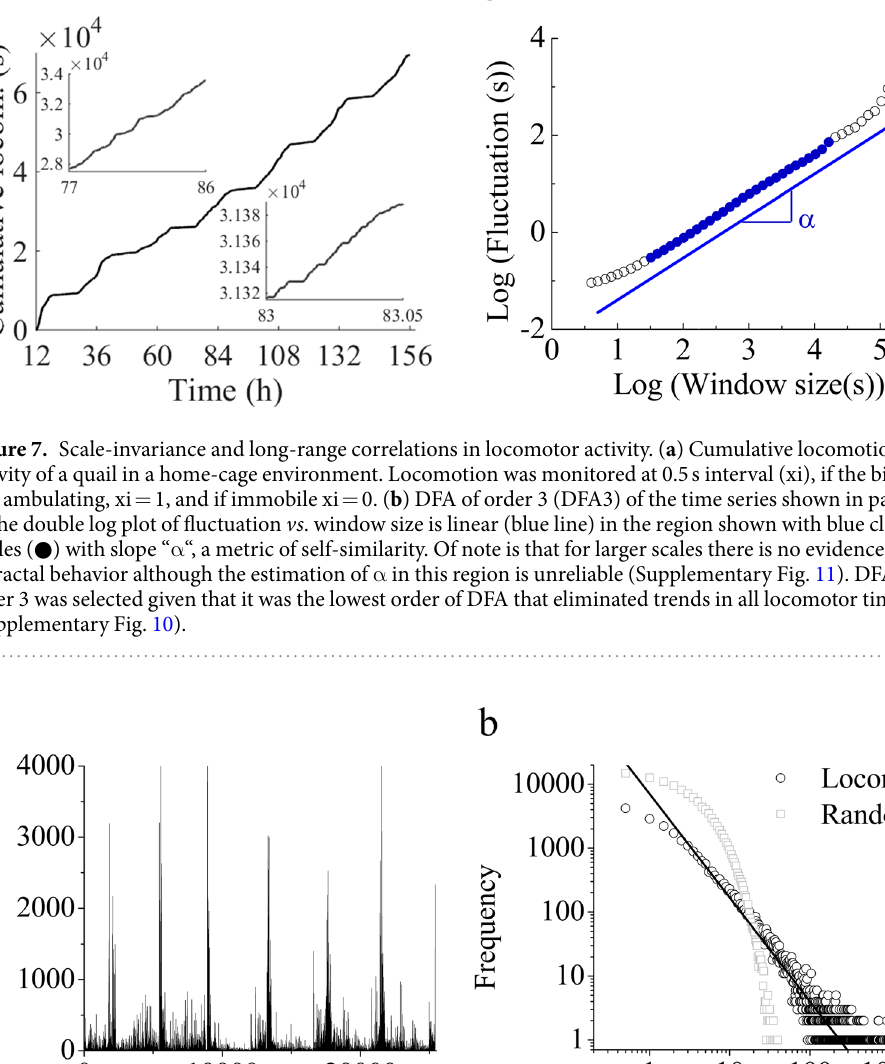
Bird species have at least three autonomous and anatomically distinct oscillators in retina, pineal gland, and hypothalamus that have been proposed to organize circadian pace making 50 . Mammals with lesions in the cir- cadian pacemaker (suprachiasmatic nucleus, SCN) can keep behavioral ultradian rhythmicity such as feeding in vole 41 and sleep in rats 51 . However, more recent studies show that circadian and ultradian rhythms in rat locomotion are almost completely abolished after SCN- lesion in agreement with its critical involvement in the scale-invariance (16 min to 24 h), and strongest influence at longer time periods ( > 4 h) 24 . Further support is pro- vided by data from humans where aging and Alzheimer’s disease (both associated with progressive dysfunction of the SCN) significantly attenuate the scale invariance of arm activity fluctuations 52 . Fluctuations in stride interval during walking also present long-range (fractal) correlations that degrade during physiological aging and certain